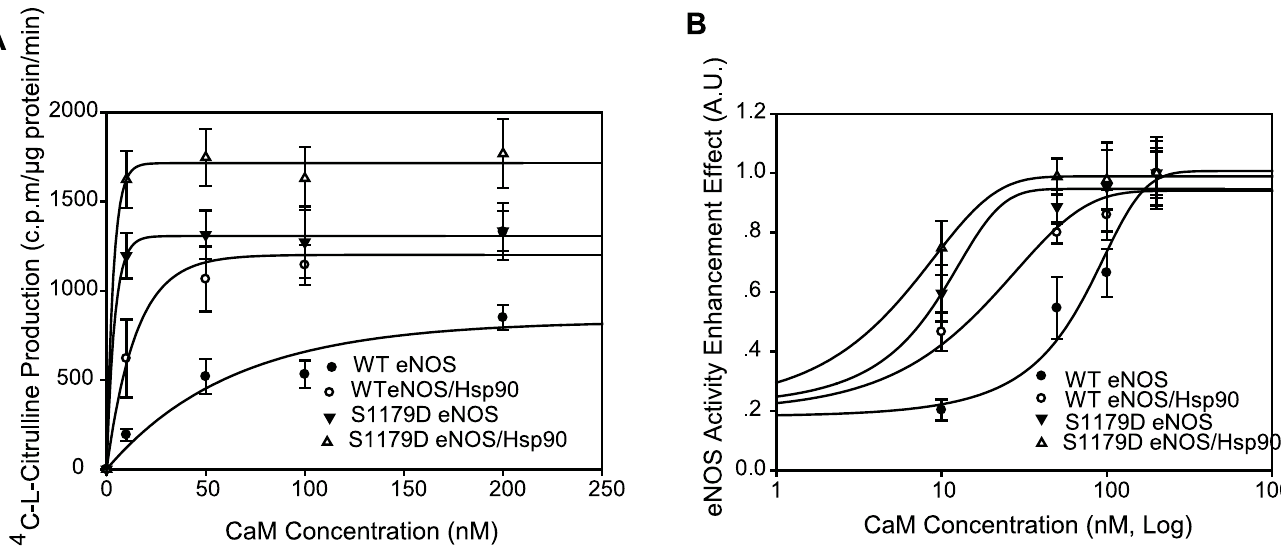
Fig 4. Hsp90 enhanced WT eNOS but not S1179DeNOS affinity to Calmodulin. (A) Hsp90 augmented both WT eNOS and S1179D eNOS activity capacity in the presenceof calmodulin (n = 5). (B) Calmodulin-eNOS activity dynamicassay showedthat Hsp90 enhanced WTeNOS (EC50, P < 0.05; n = 5) but not mutant S1179D sensitivity to calmodulin (EC50, P > 0.05; n = 5). However,mutation of S1179D significantly enhanced eNOS affinity to calmodulin comparedto their WT eNOS control in the absenceor presenceof Hsp90 (EC50, P < 0.05;n= 5).